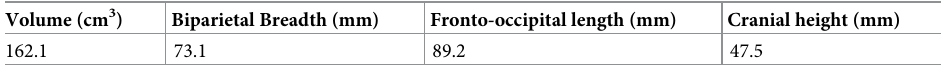
Table 5. Estimated neonatal cranial dimensions for A . sediba . Regression-based estimate of neonatal cranial capacity using the published brain size of MH1 from methods in